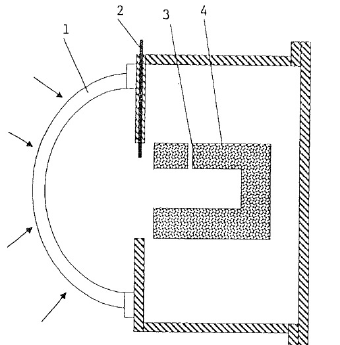
Figure 6. Reactor/receiver configuration for the direct thermolysis of water (1, Pyrex window; 2, silica tube for quenching; 3, H 2 O feed section; 4, insulating brick and cavity). Reprinted from [60] with permission from